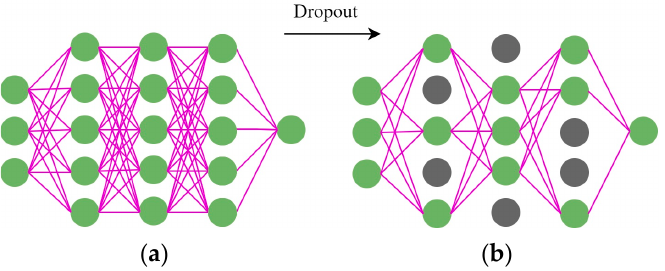
Figure 5. Flow chart of dropout method (Note: the green circles represent normal neurons, and the gray circles represent inactivated neurons). ( a ) the fully connected network; ( b ) the network after applying Dropout.